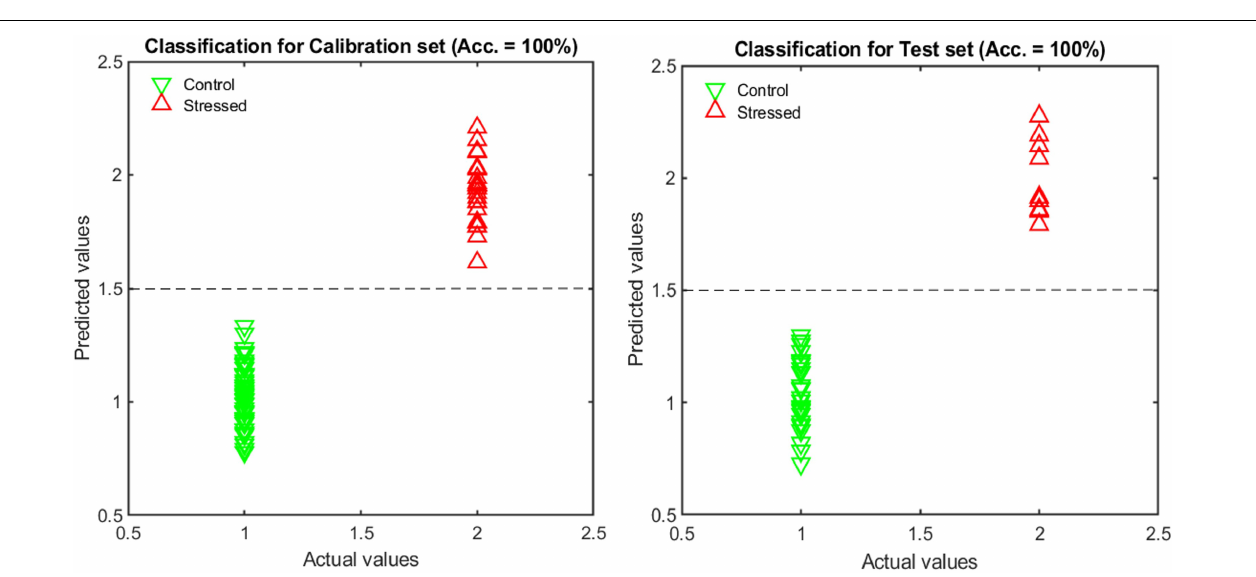
Frontiers in Plant Science |